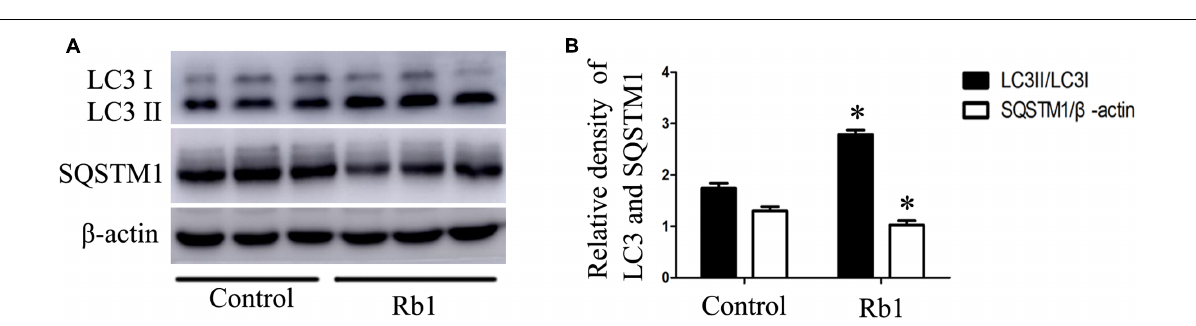
FIGURE 5 | Rb1 increased autophagy levels in atherosclerotic plaques in apoE − / − mice. (A) Representative western blot analysis and (B) quantification of LC3-II and SQSTM1/p62 in vivo . ∗ p < 0.05, compared to the control group, n =